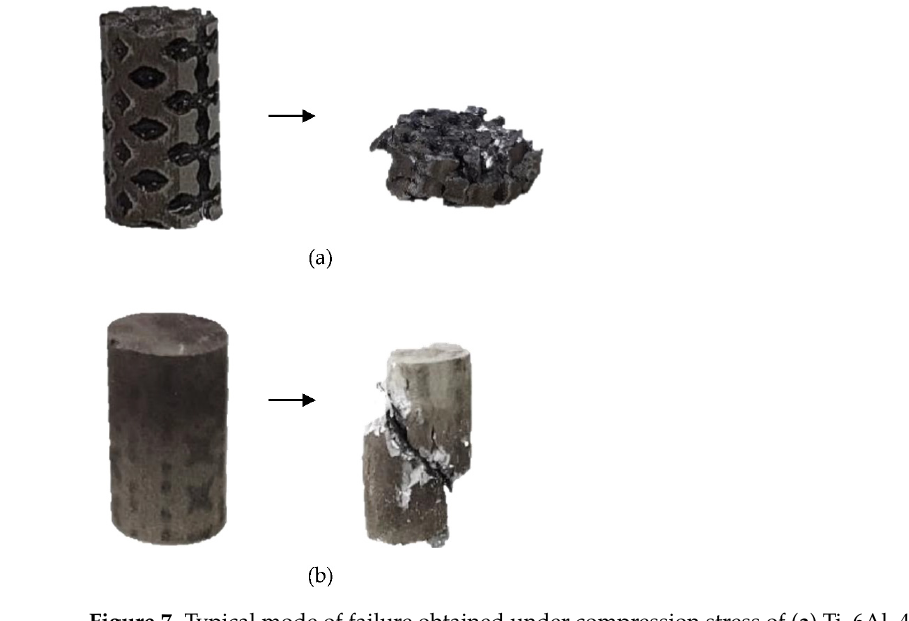
Figure 7. Typical mode of failure obtained under compression stress of ( a ) Ti–6Al–4V lattice, ( b ) OI– TiZn system.